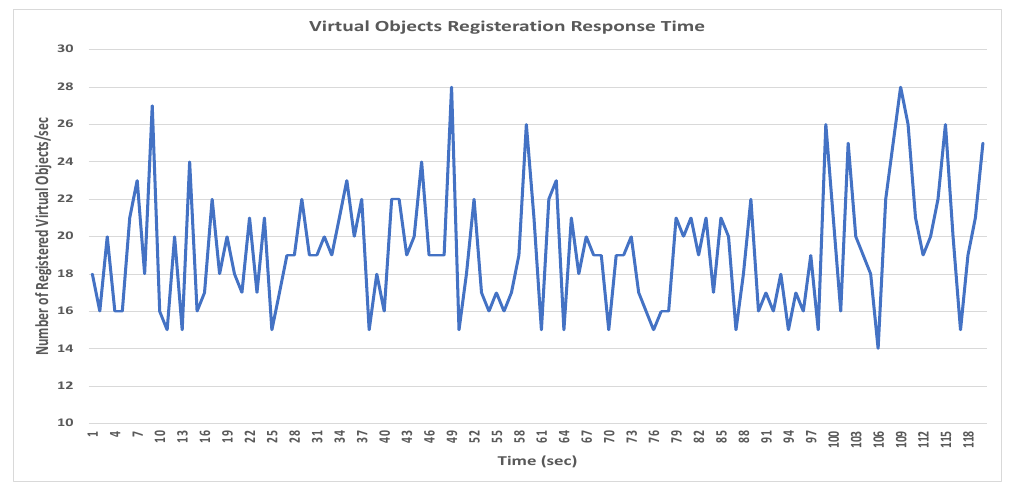
Figure 10. Virtual object registration response time.